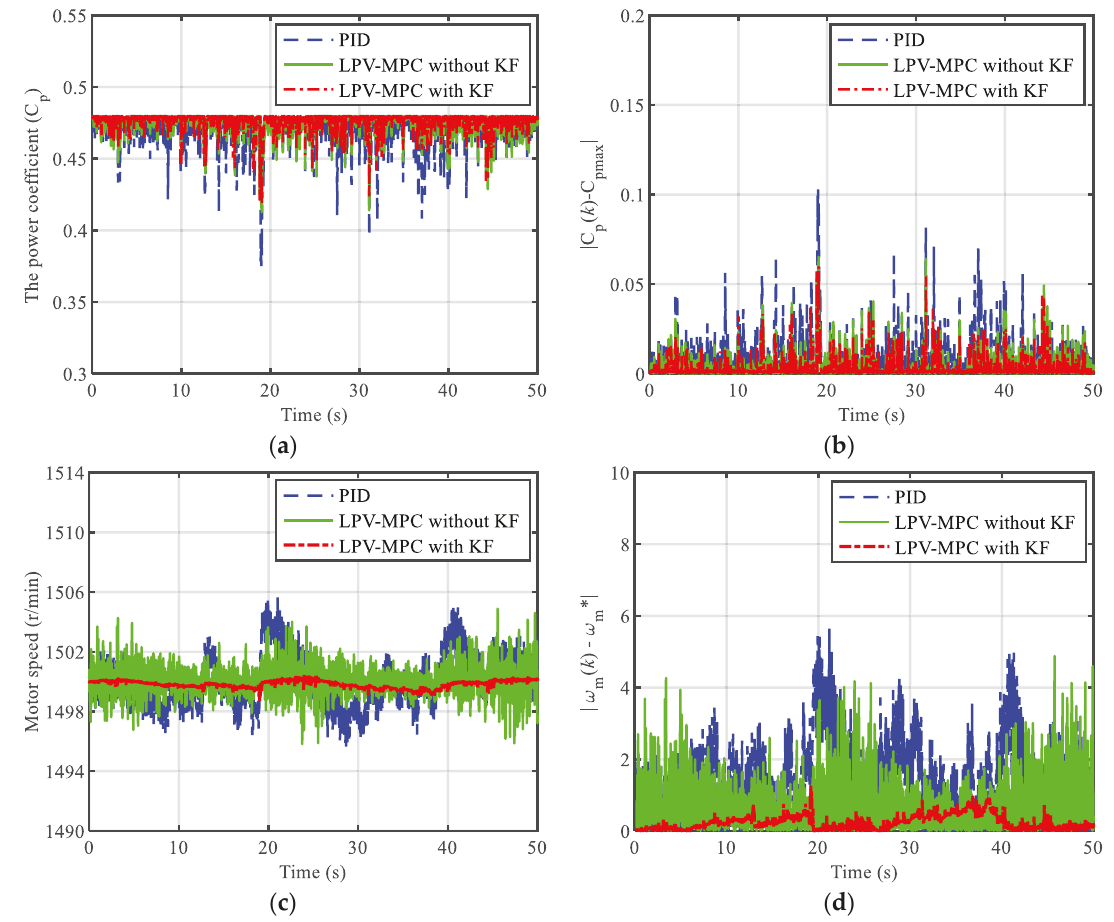
Figure 6. Comparison of power coefficients and variable motor speeds under different control methods in scenario 3: ( a ) power coefficient; ( b ) absolute error of power coefficient; ( c ) variable motor speeds; ( d ) absolute error of variable motor speeds. Table 3. RMSE at different wind speeds with turbulence